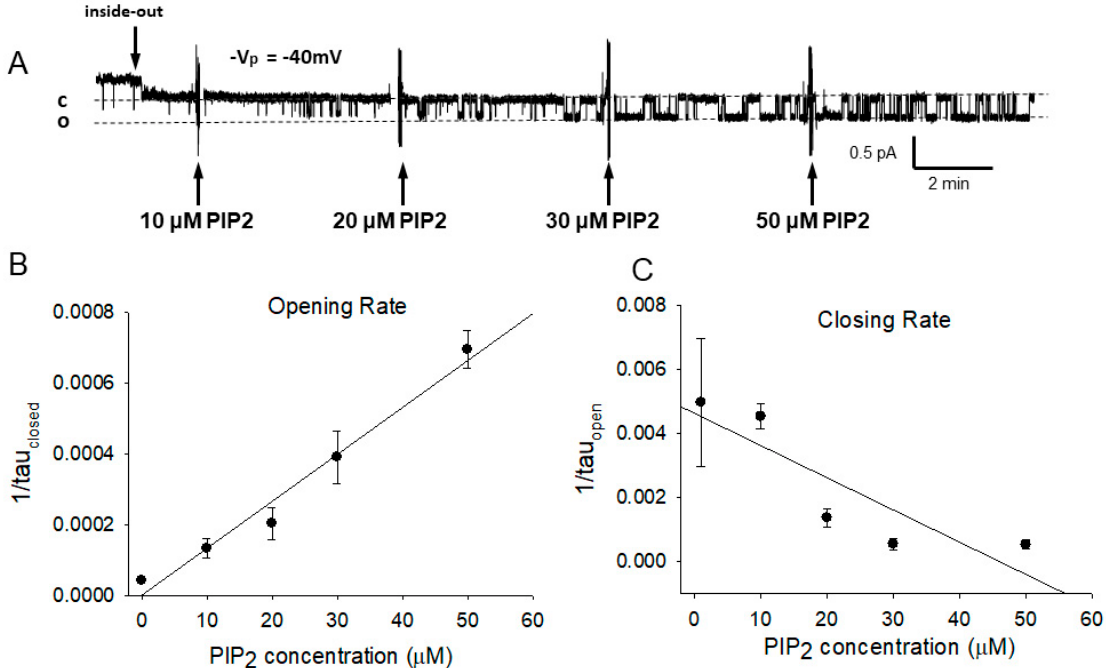
Figure 2. PIP 2 activates ENaC. ( A ). Single channel record from an excised cell-free patch from an H441 epithelial cell. After excising the patch bathed in a solution that mimics the intracellular ion composition, we added increasing doses of PIP 2 to the cytosolic surface of the patch. Mean closed time decreases. This implies an increase in the opening rate as shown in Panel ( B ) (slope = 7.97 × 10 − 6